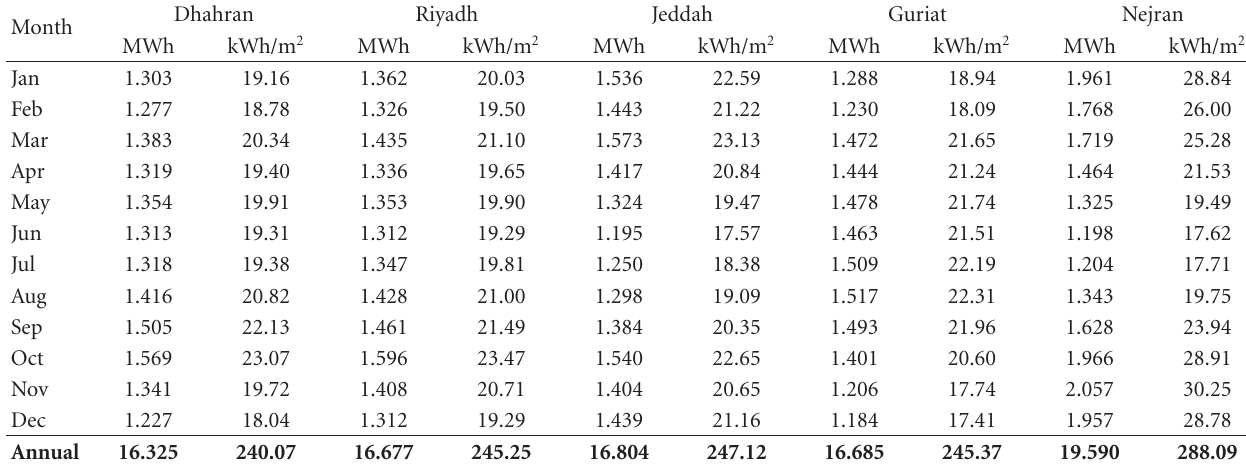
Table 4: Annual energy delivered and energy density for all the stations under consideration.